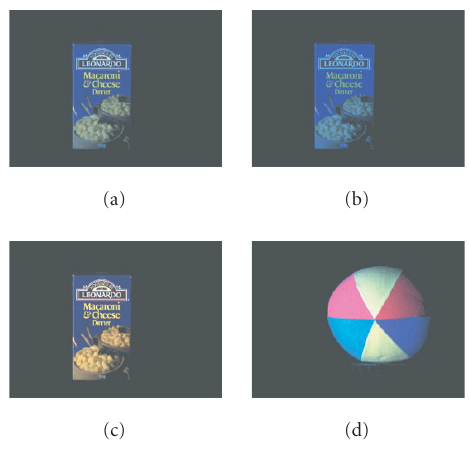
Figure 1: As the images (a), (b), and (c) contain the same object subject to di ff erent illumination during the acquisitions, they are similar. As the image (d) contains another object, the pairs of im- ages ((a), (d)), ((b), (d)), and ((c), (d)) constitute pairs of di ff erent